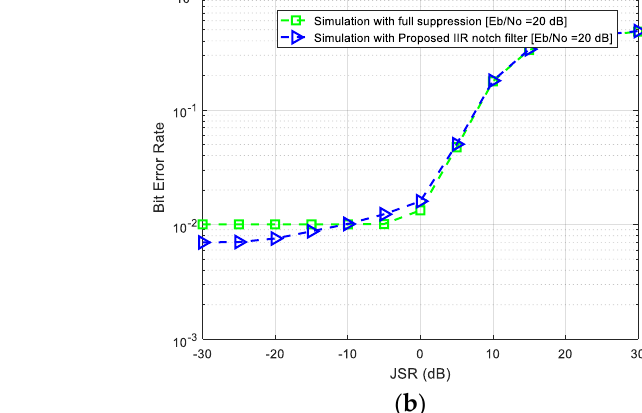
Figure 17. BER vs. JSR (using MANF; full suppression means k 1 = 1): ( a ) E b / N o = 15 dB, and ( b ) E b / N o = 20 𝑑𝐵